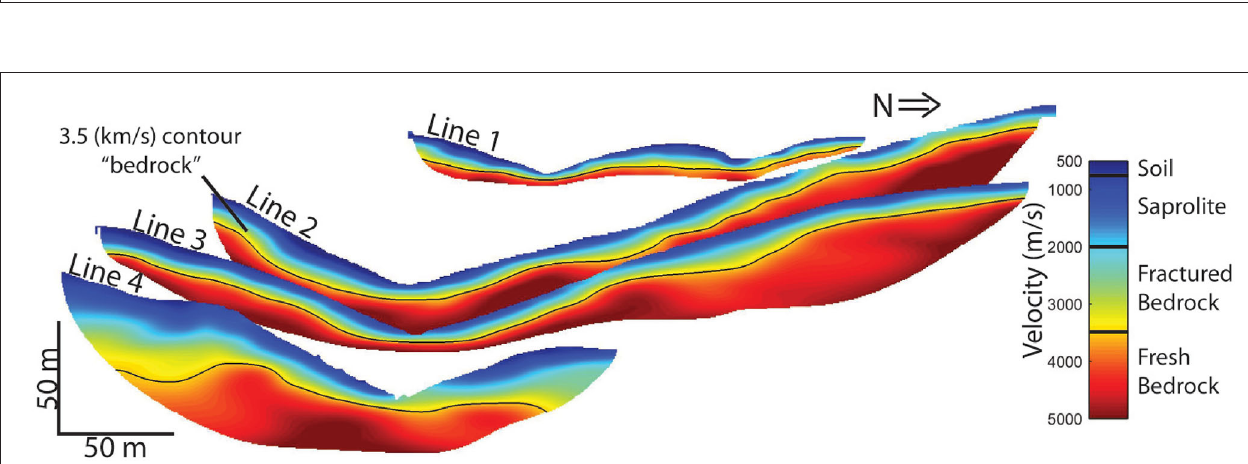
FIGURE 7 | Fence diagram looking up drainage of the inverted velocity profiles within Johnston Draw with no vertical exaggeration. The black lines are the 3.5 km/s velocity contour which we interpret as the top of unweathered bedrock.